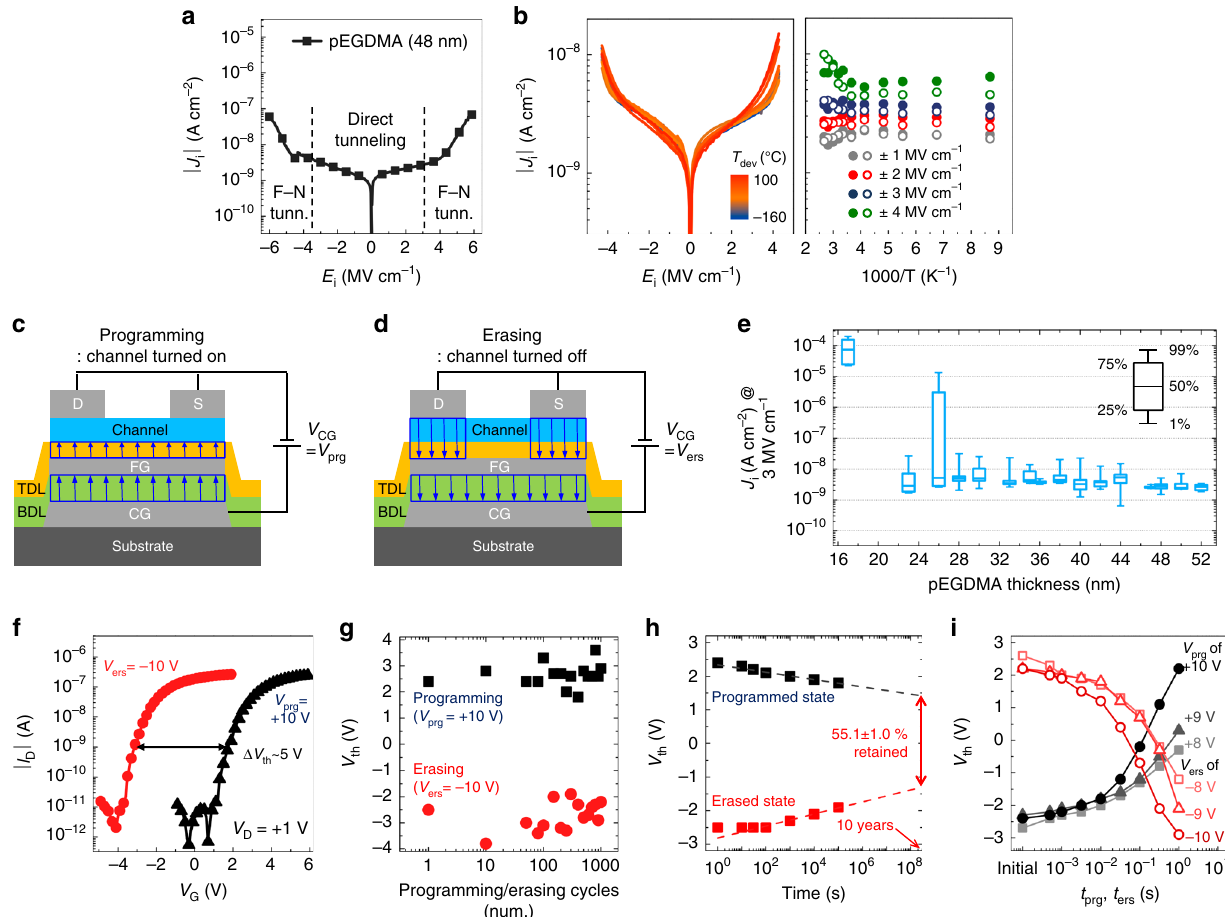
Fig. 2 Properties of iCVD-processed polymer dielectric layers and an organic fl ash memory made thereof on plastic substrates. a | J i | vs. E i characteristics of a Al/pEGDMA (48 nm)/Al device. The vertical , dashed lines are a guide to eyes that divides low- fi eld, direct-like tunneling regime and high- fi eld, Fowler – Nordheim ( F – N )-like tunneling regime. The latter can be easily distinguished from the low- fi eld regime due to the clear fi eld-enhanced J i over E i . In both regimes, it is likely that each tunneling mechanism is coupled with trap-assisted tunneling (TAT) 57, 58 . b | J i | – E i characteristics of Al/pEGDMA (36 nm)/Al devices measured at various device temperatures ( T dev ) ( left ) and Arrhenius plots ( right ) transformed from them. c , d Sketches of electric fi eld (shown as arrows ) distribution inside fl ash memory under programming ( c ) and erasing ( d ) operations. e Statistical distribution of J i at E i of 3 MV cm − 1 obtained for the Al/pEGDMA/Al devices with various pEGDMA thicknesses. f – i Device characteristics of the proposed fl ash memories fabricated on a PET substrate: transfer memory characteristics ( f ), endurance test result over repeated programming/erasing operations ( g ), data retention characteristics ( h ), and memory speed characteristics for various programming/erasing voltages ( i ). All the transistor and memory characteristics in Fig. 2 and those appearing later have been measured under controlled atmosphere in an N 2 - fi lled glove box, unless speci fi